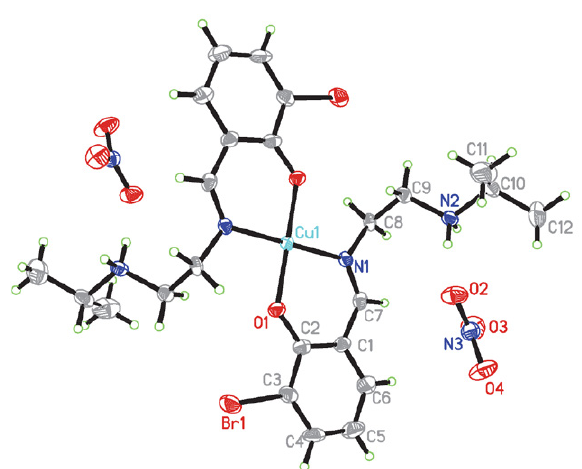
Figure 3. A perspective view of complex 3 with the atom labeling scheme. Thermal ellipsoids are drawn at the 30% probability level.